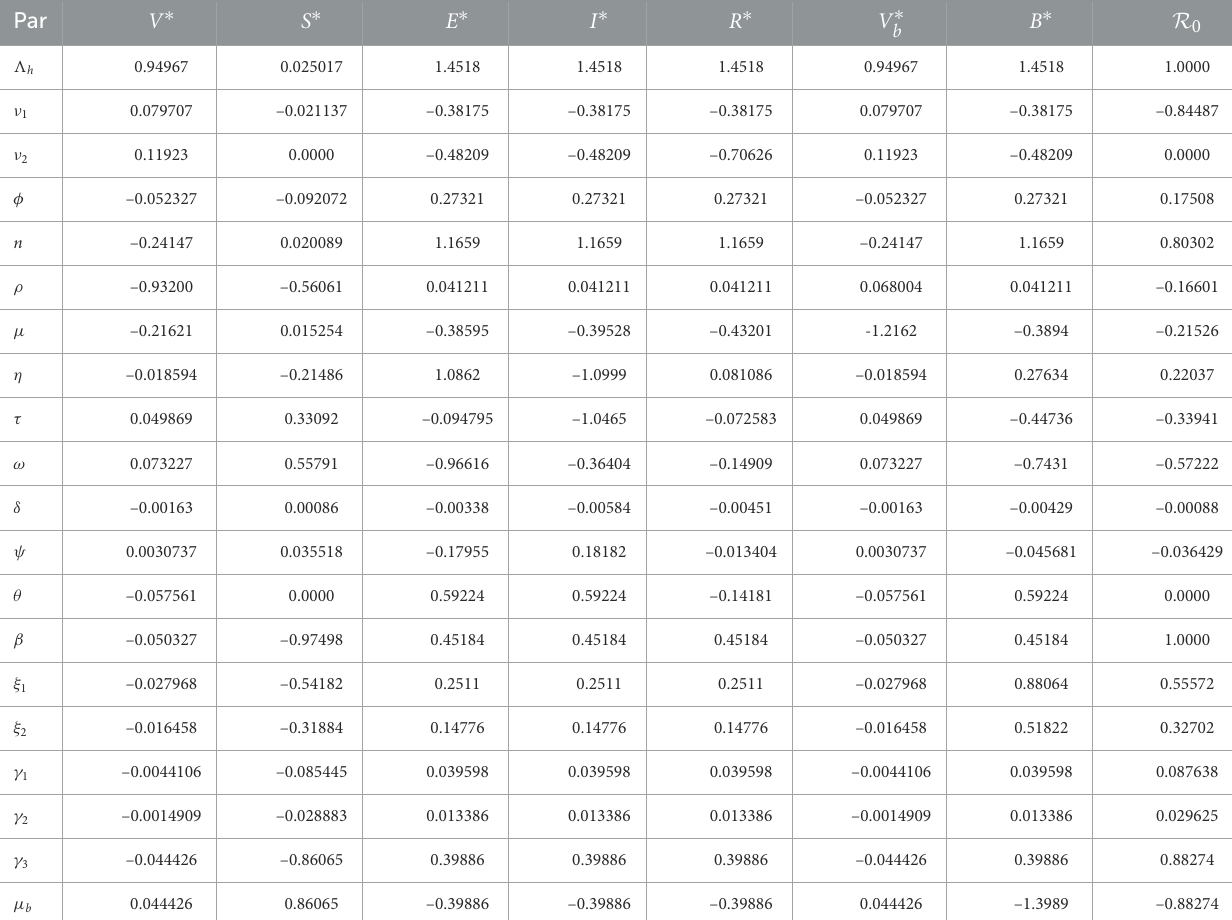
TABLE 2 Sensitivity indices of endemic equilibrium and R 0